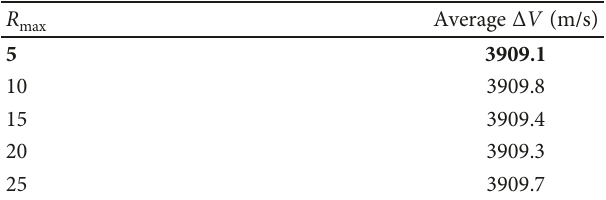
(b) Performances for the maximum number of random reinitialization on the Earth-Moon low-energy transfer